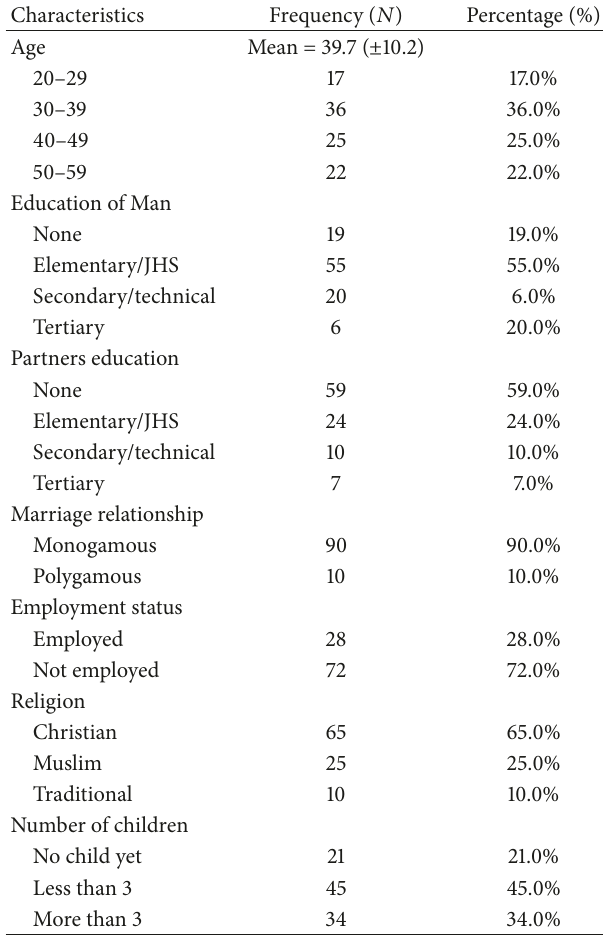
Table 1:Sociodemographic characteristics ofmalerespondent( 𝑁 = 100